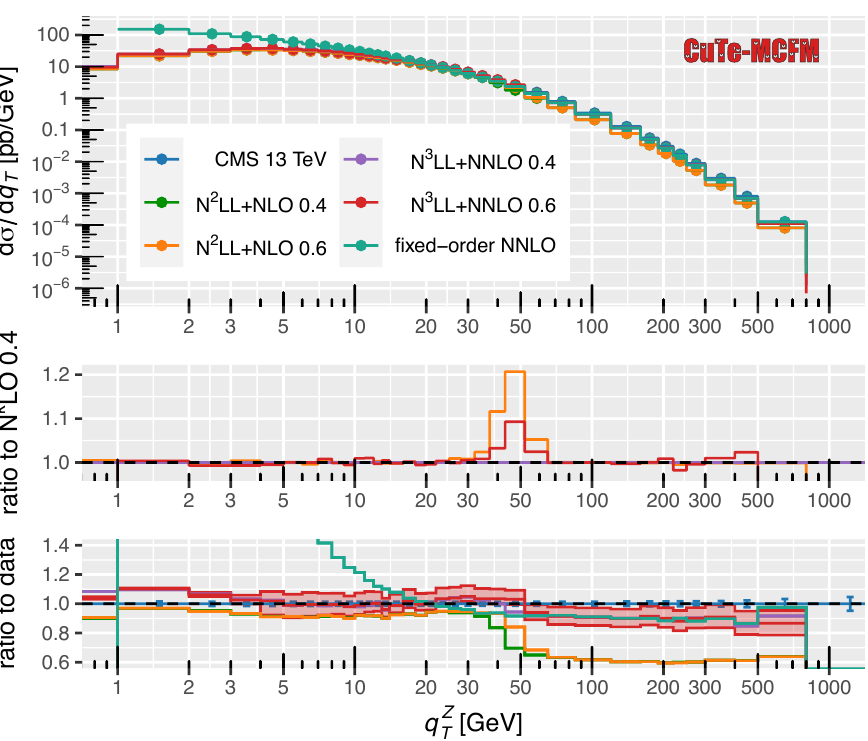
Figure 9. Predicted and measured transverse-momentum distribution of the Z boson with fiducial cuts as in the CMS study [100] at 13 TeV . The middle panel shows the effect of varying the transition function, while the bottom panel shows the ratio to data with estimated scale uncertainties.